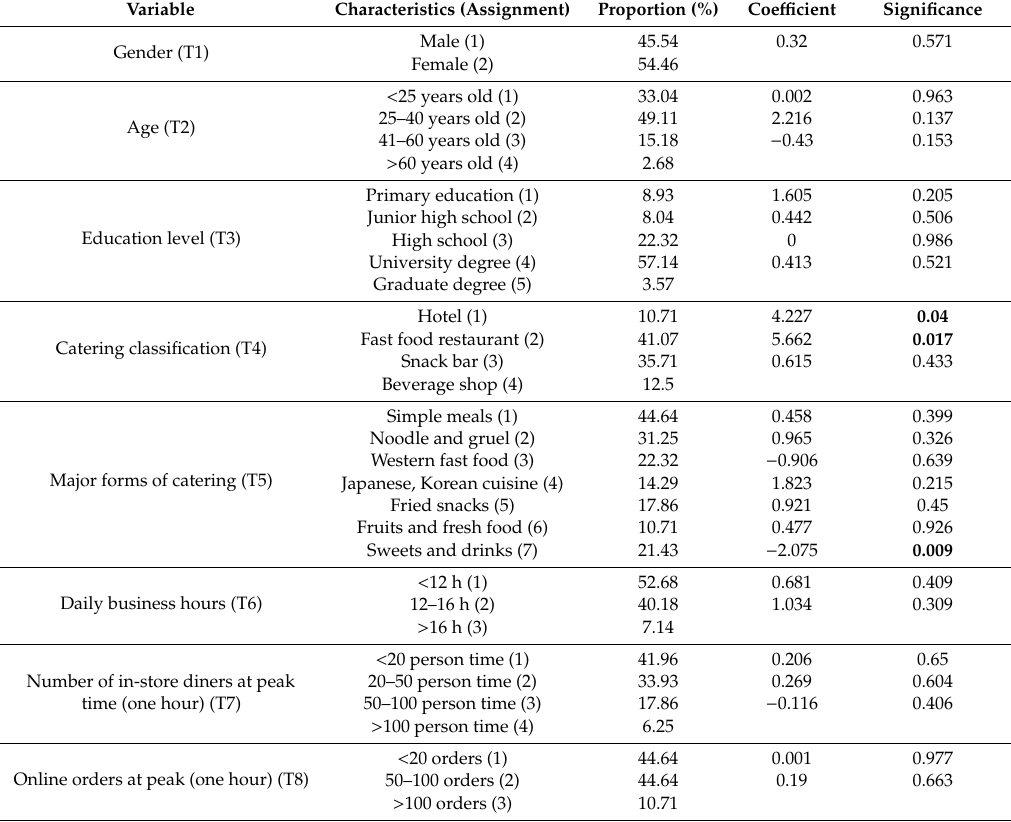
Table 5. Characteristics of the merchant survey samples and the regression analysis results of the merchants’